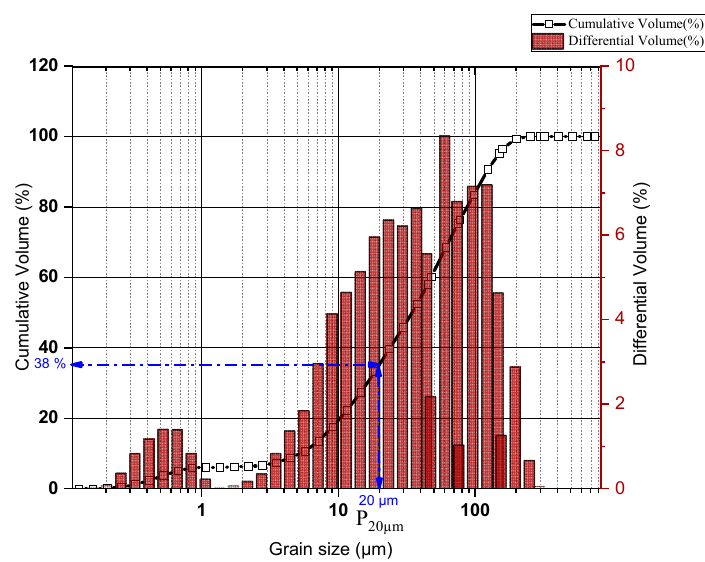
Figure 1. Particle size distribution of tailings.